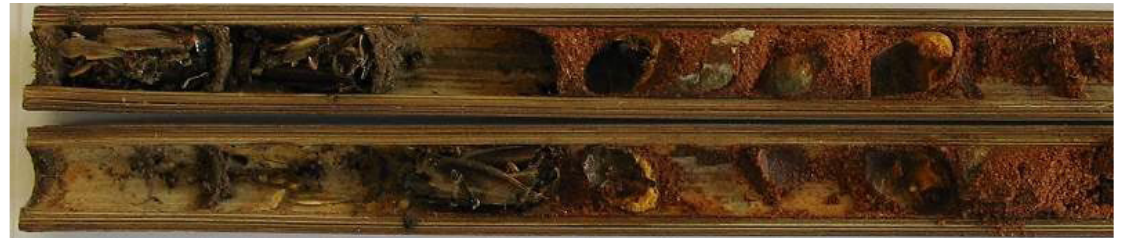
Fig 5 . Nest foundation by Centris sp., followed by nesting of P . denticulatum in a